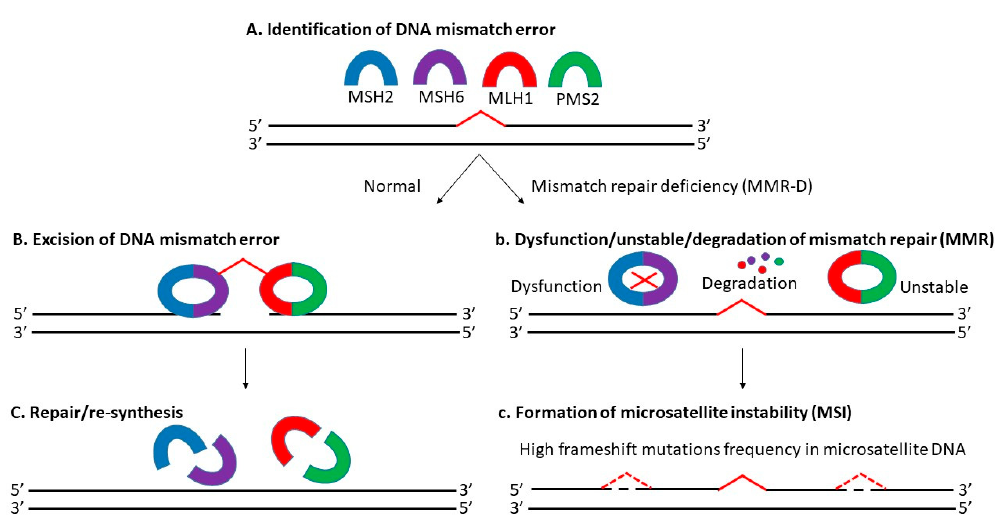
Figure 1. ( A – C ) Functioning mismatch repair system (MMR) capable of repairing DNA mismatch error, whereas ( b , c ) Defective mismatch repair system (MMR-D) which resulted in microsatellite instability (MSI).